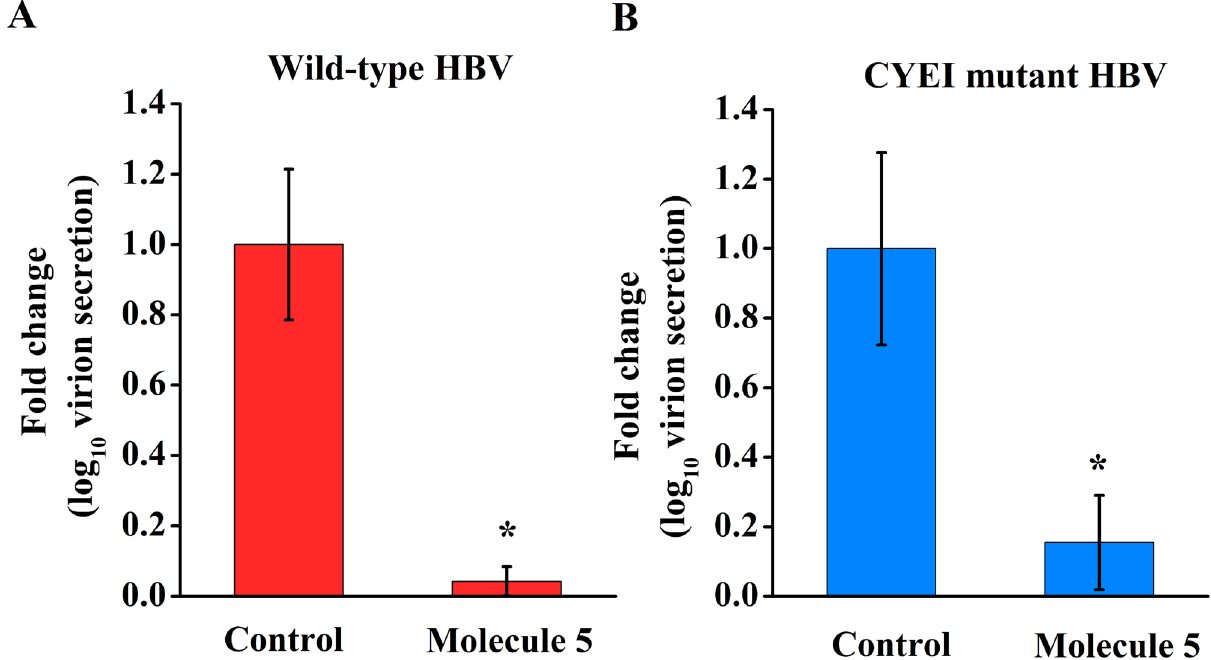
Figure 5. Inhibition of Secreted hepatitis B virion (log 10 copies)/ml supernatant ( A ) Wild-type HBV and ( B ) Tenofovir resistant CYEI mutant HBV by 10 µM Molecule 5 normalised to control was estimated using real-time PCR following virion capture as described in the methods section. Values significantly different from controls are indicated by a Student’s t-test where, * p <